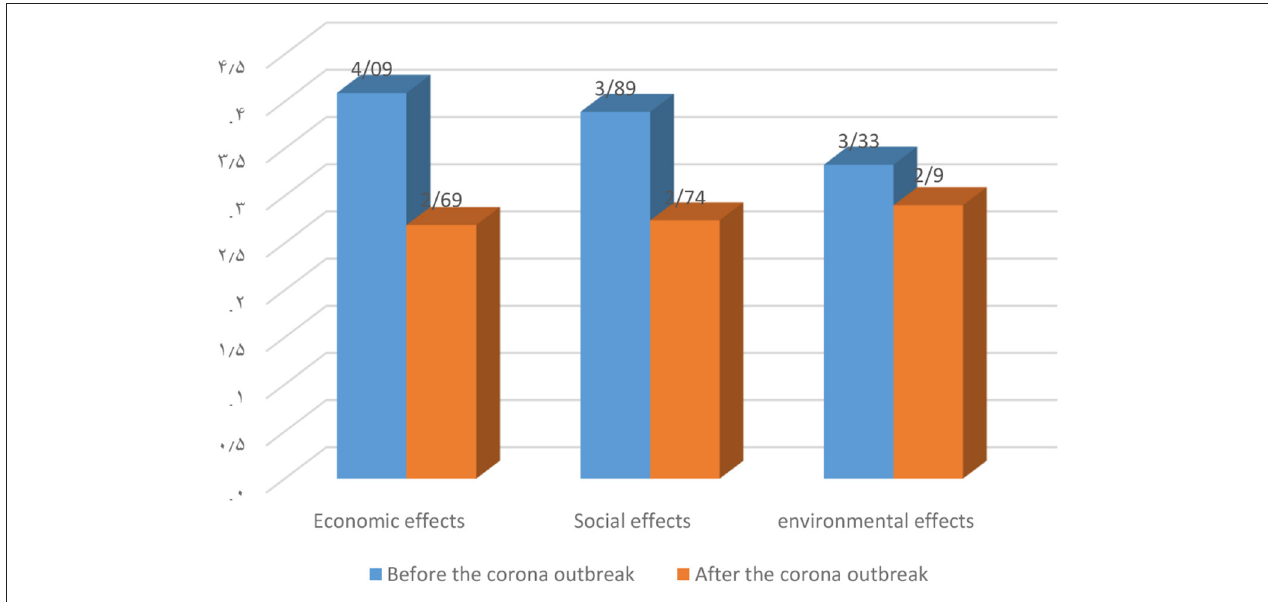
FIGURE 2 | Assessing the economic, social and environmental impacts of the Corona outbreak in experts’